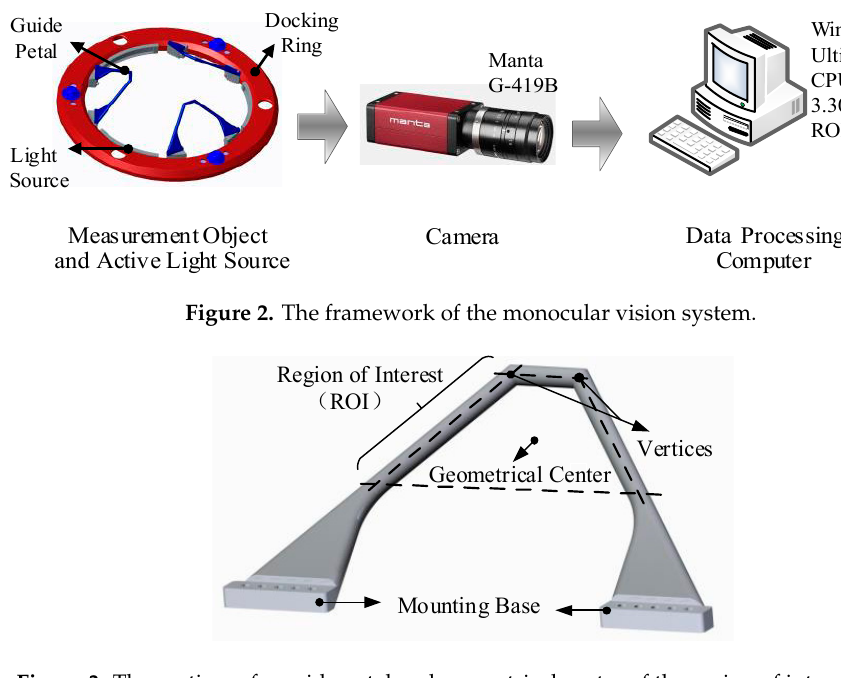
Figure 3. The vertices of a guide petal and geometrical center of the region of interest (ROI).